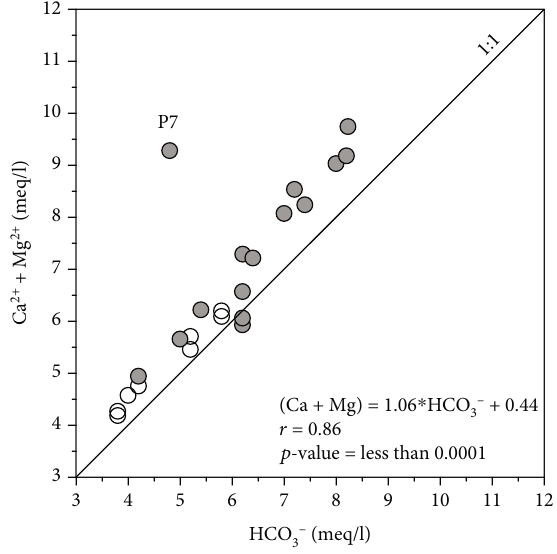
− concentrations. 3